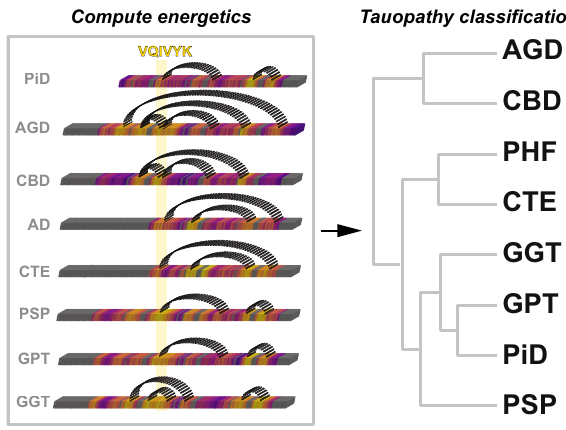
Fig. 7 | Classi fi cation of tau fi bril structures using per residue energetics. Contacts observed in fi brils between energetically important hetero-typic interac- tions determine tauopathy folds. The linear heatmaps are shown as 3D rendered boxes that are colored by the normalized change in energy values (yellow= stabilizing and purple=neutral). Dashed semi-circles link contacts between hot- spot regions that interact in the different structures and are used to classify the different